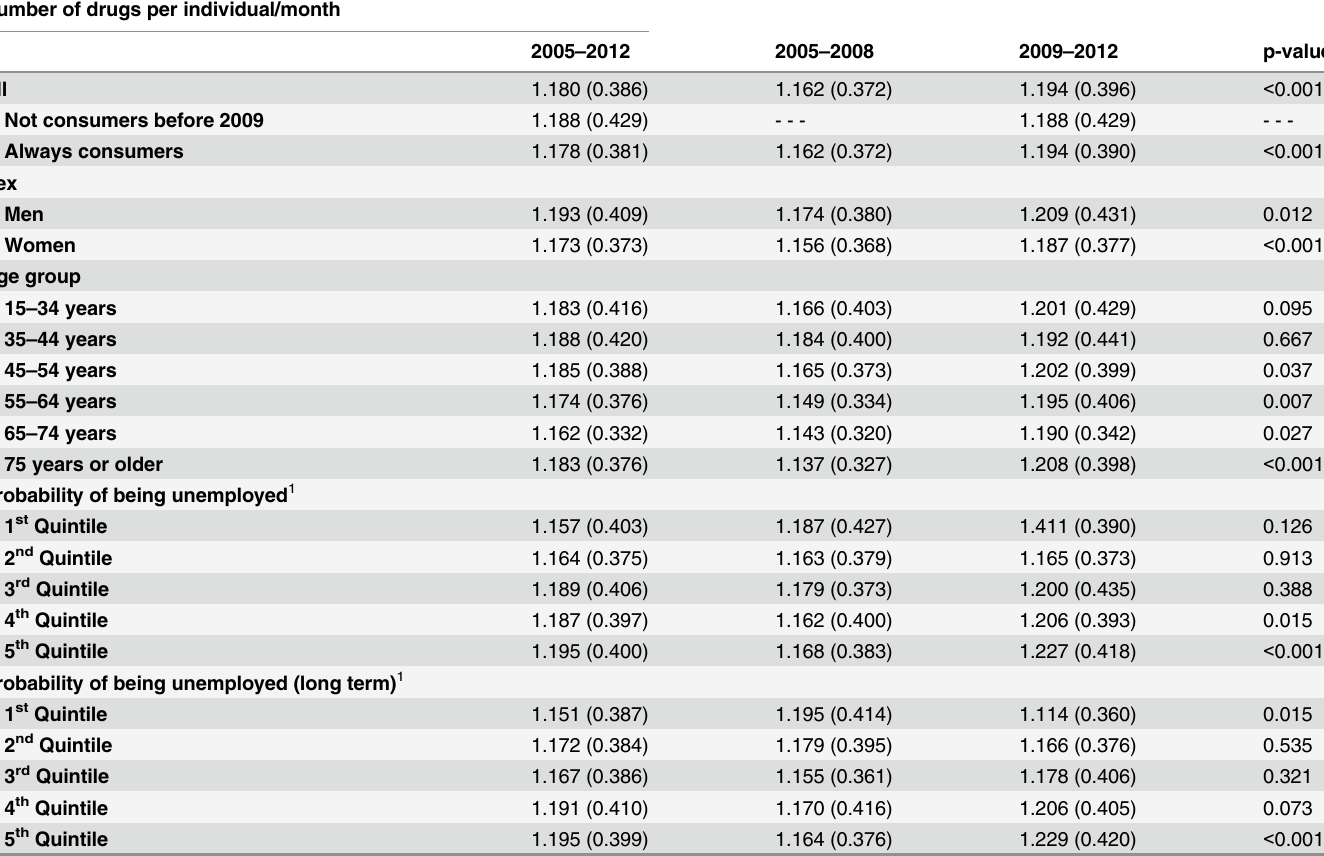
Table 2. Consumption of psychotropic drugs. Number of drugs per